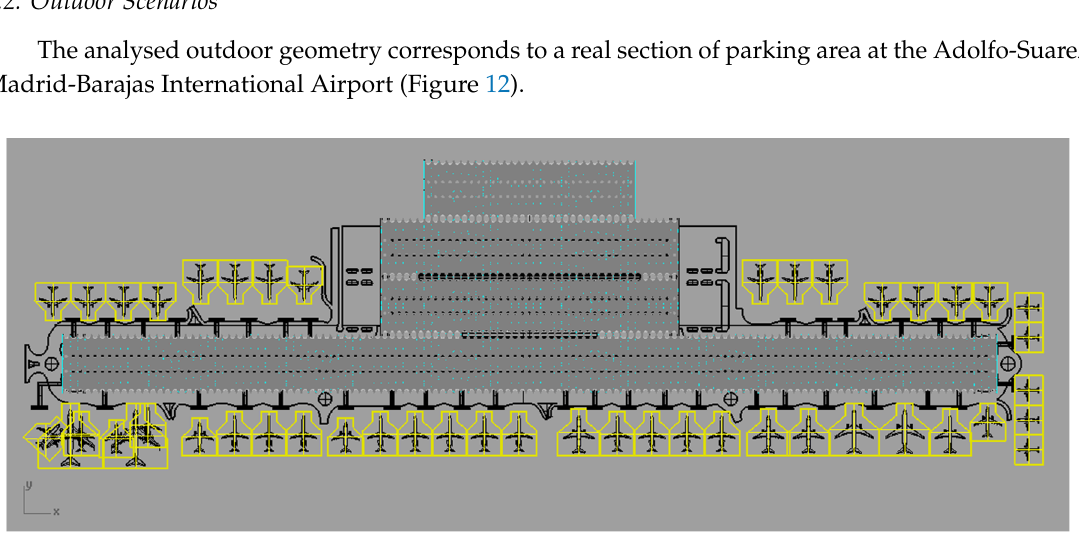
Figure 12. Outdoor scenario: Terminal 4 at Adolfo-Suarez Madrid-Barajas International Airport.